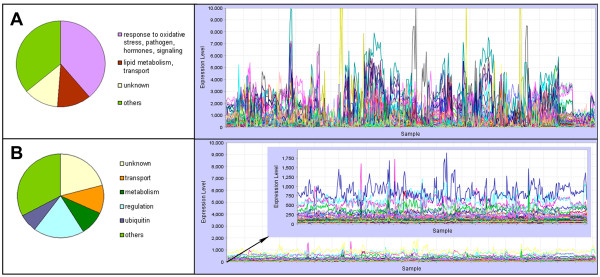
Functional assignments and expression profiles of genes with the most and the least variable expression across multiple conditions. (A) 100 genes with the most variable expression (highest standard deviation of logE). (B) 100 genes with the most steady expression (lowest standard deviation of logE). The scale along Y axis (expression values) is the same for both plots to facilitate comparison of the expression profiles between them. Inlet shows a version of plot B with zoomed scale of expression values.